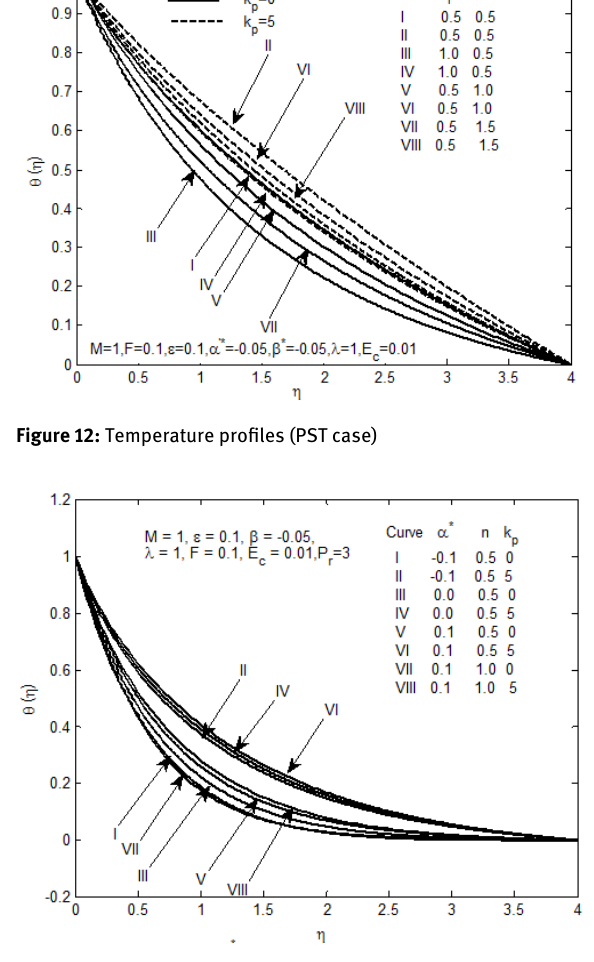
Figure 13: Temperature profiles (PST case)